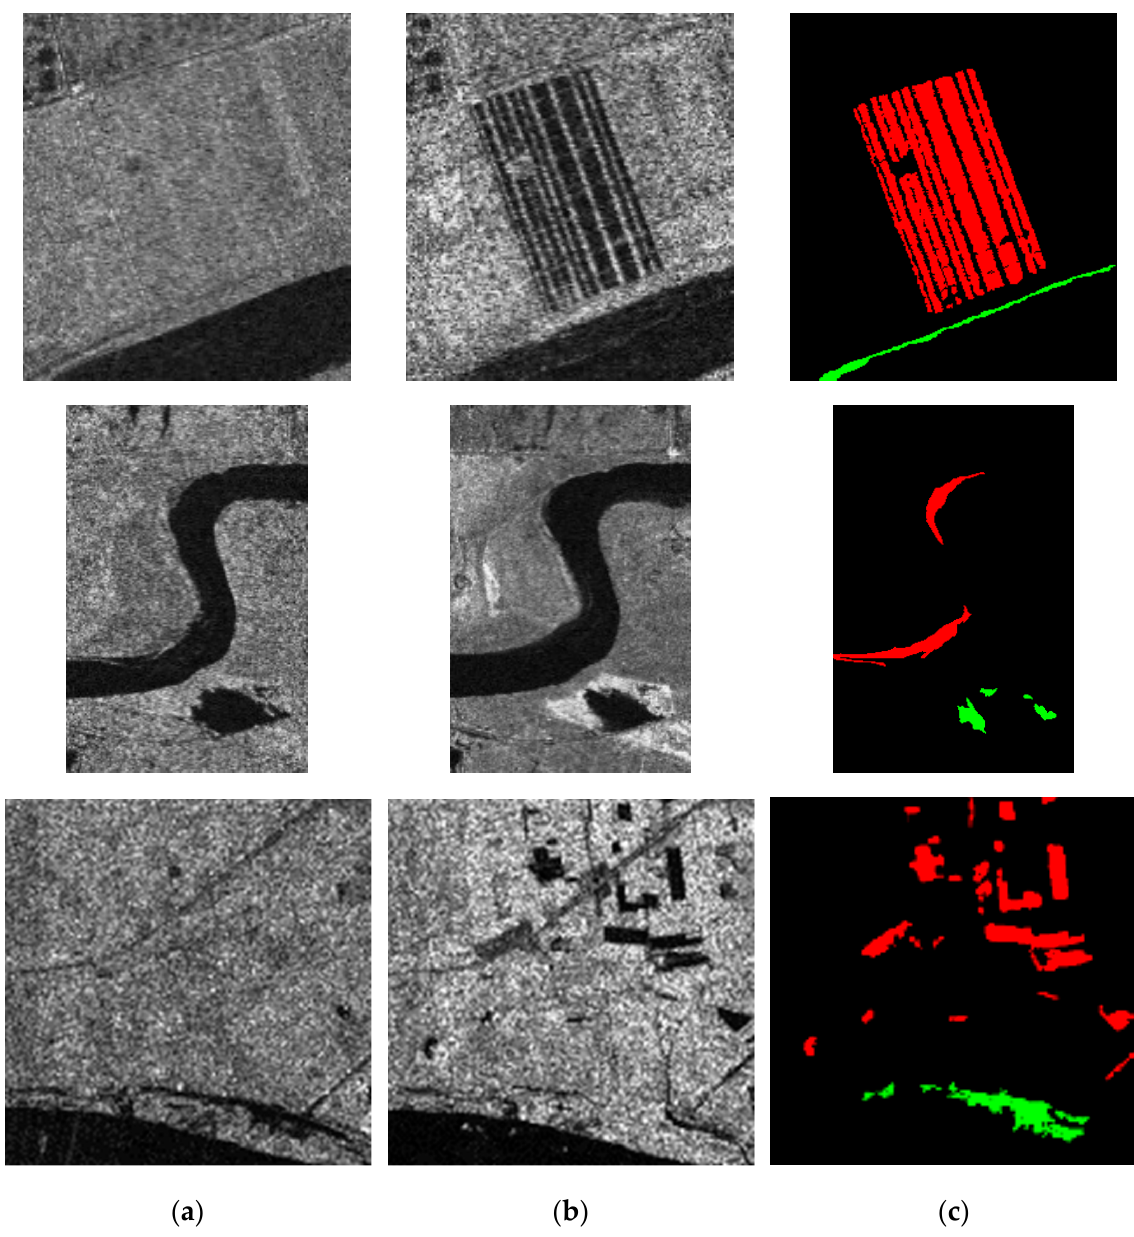
Figure 4. Datasets of change type recognition. The first row is the A dataset of the Yellow River Estuary. The B dataset of the Yellow River is seen in the second row, whereas the C dataset of the Yellow River is presented in the third row. ( a , b ) the two original SAR images, respectively; ( c ) the change recognition reference chart. Table 2. Details of a real SAR data set.